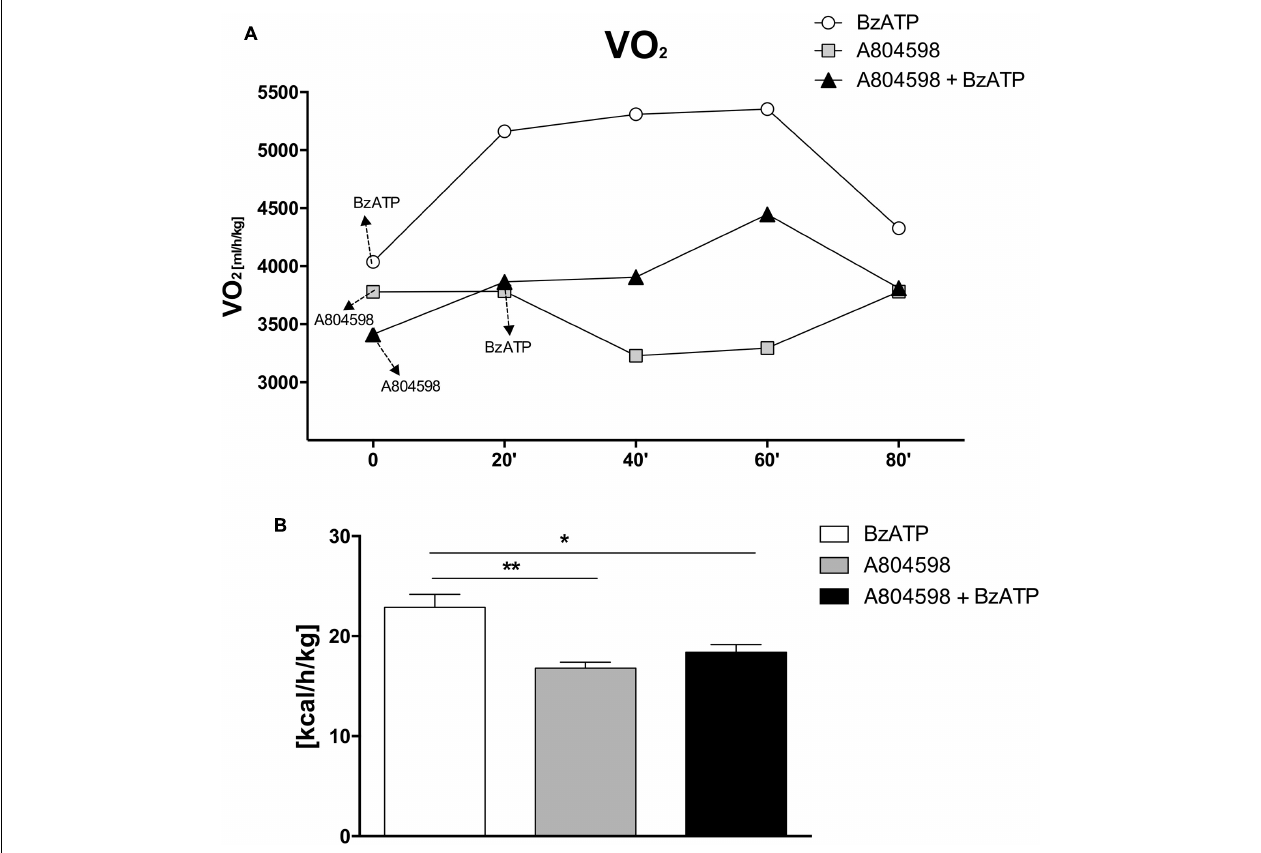
FIGURE 3 | A804598 administration prevents the BzATP-dependent increase of energy expenditure. Female C57BL/6J mice ( n = 4) after adapting to the metabolic chambers for 24 h, were subjected to IC recording for 3 consecutive days according to the subsequent experimental design: day1, a single BzATP 1 mg/Kg i.p. injection and IC recording for 24 h,; day 2, a single A804598 90 mg/Kg i.p. injection and IC recording for 24 h; day 3, A804598 injection followed (after 20 min) by BzATP and IC recording for 24 h. (A) Mean ( ± SEM) 24 h metabolic activity is expressed as volume of oxygen consumption rate (VO 2 ) (ml/h/kg). (B) Mean ( ± SEM) EE energy expenditure is expressed as Kcal/h/Kg. ( ∗∗ P < 0,001 BzATP vs. A804598, ∗ P < 0,005 BzATP vs. A804598 +